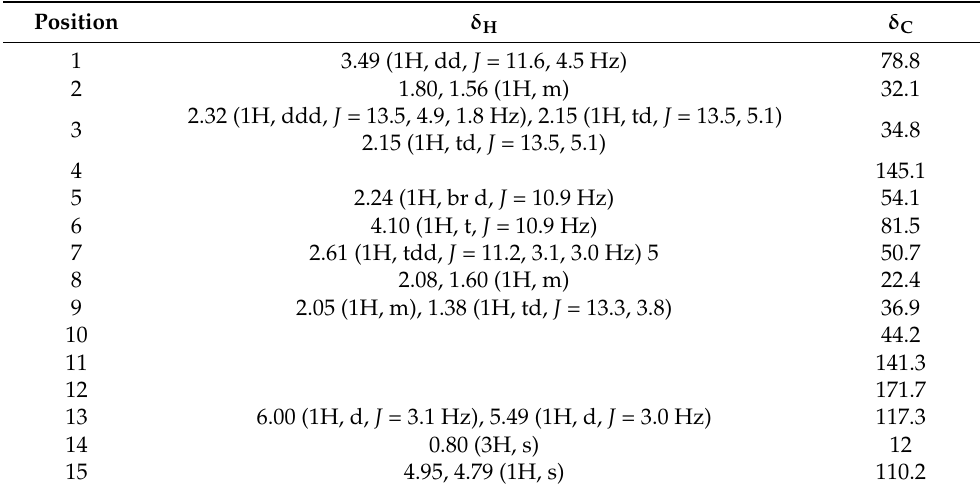
Table 1. 1 H and 13 C NMR spectral data for reynosin *.